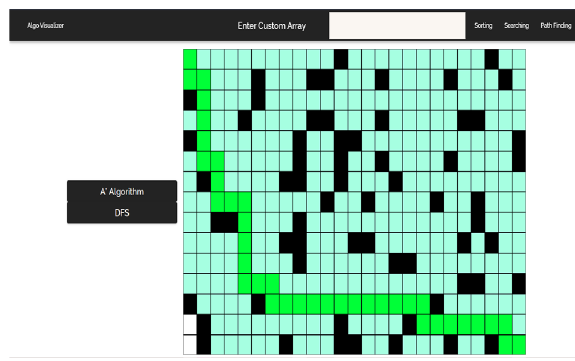
Fig.7 . A star path finding Algorithm Animation